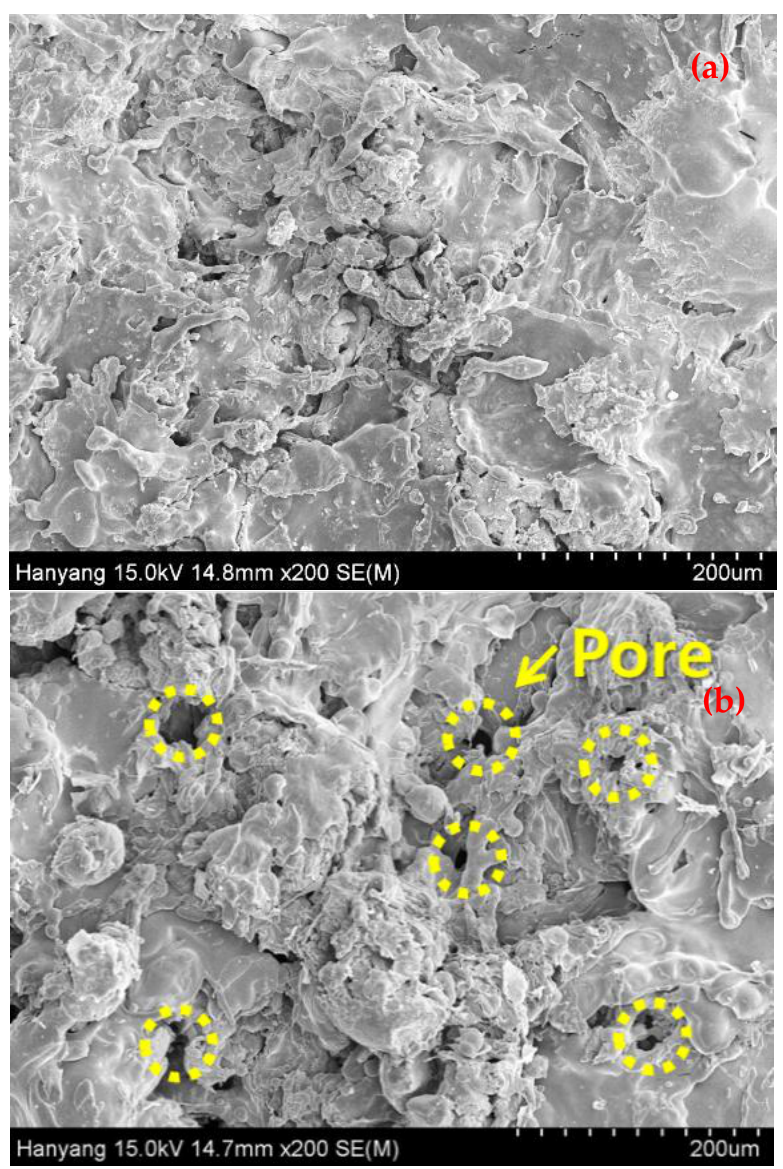
Figure 7. SEM image of the specimen surface of ( a ) MS-Zn-Al 100 and ( b ) MS-Cu 100.